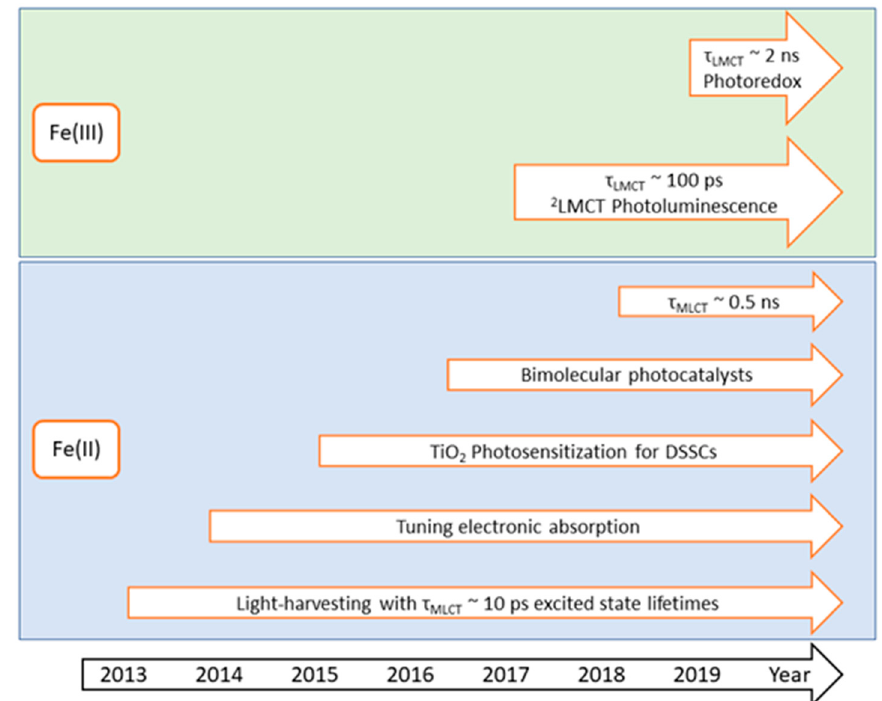
Figure 2. Timeline highlighting selected key developments for Fe(II) and Fe(III) N -heterocyclic carbene NHC complexes discussed in the text.